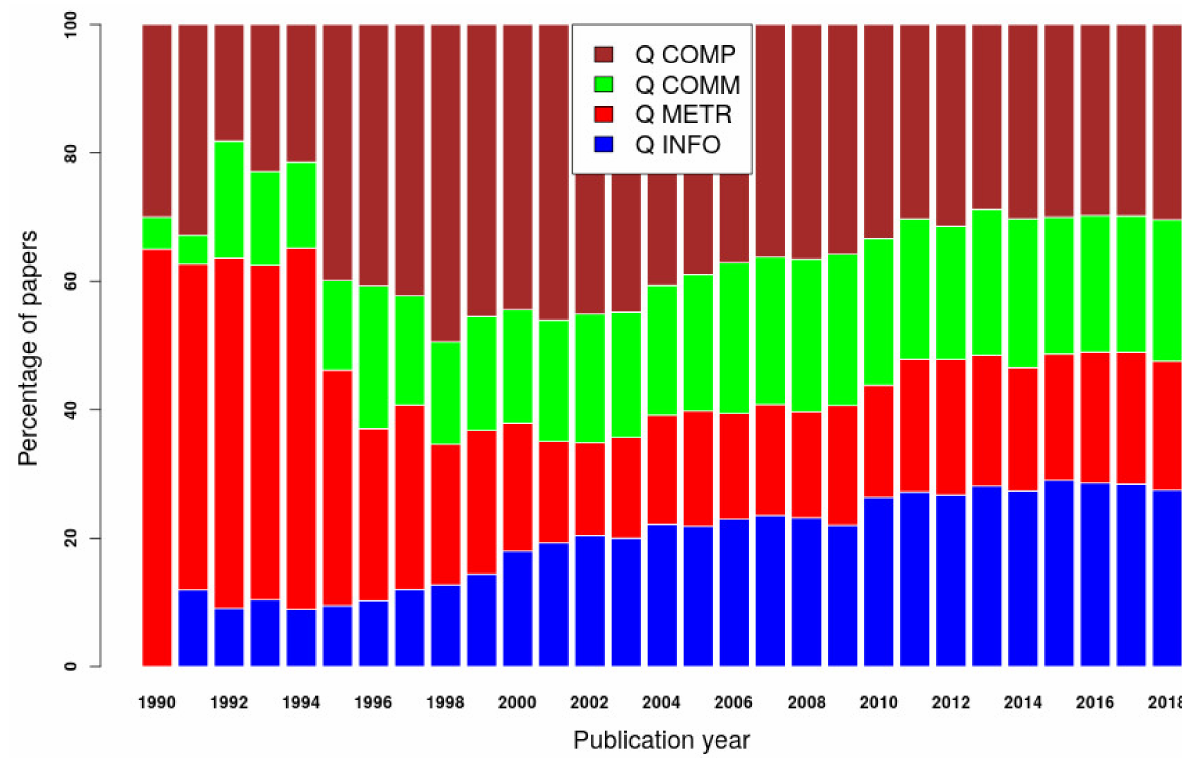
Figure 3. Annual percentages of the four different fields of QT 2.0 from 1990 to